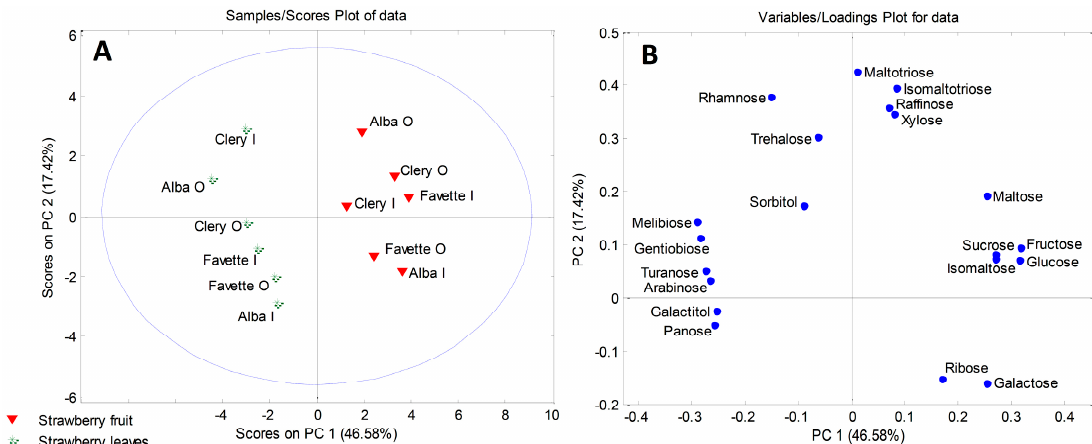
10 of 17 Figure 2. PCA model for sugar-based classification and differentiation of blueberry and strawberry leaves: ( A ) score plot; ( B ) loading plot. In addition, PCA was performed in order to determine sugars responsible for the separations between leaves and fruits of strawberry and blueberry samples. The six-component model explained 92.15% (for strawberry samples) and 94.97% (for blueberry samples) of the total variance. Factor scores and their loadings were shown in Figures 3 and 4. Both score plots revealed clustering of fruits and leaves into two distinctive clusters along PC1 (Figure 3A and 4A). According to Figure 3B, strawberry leaves separated from fruits based on the presence of carbohydrates exclusively found in